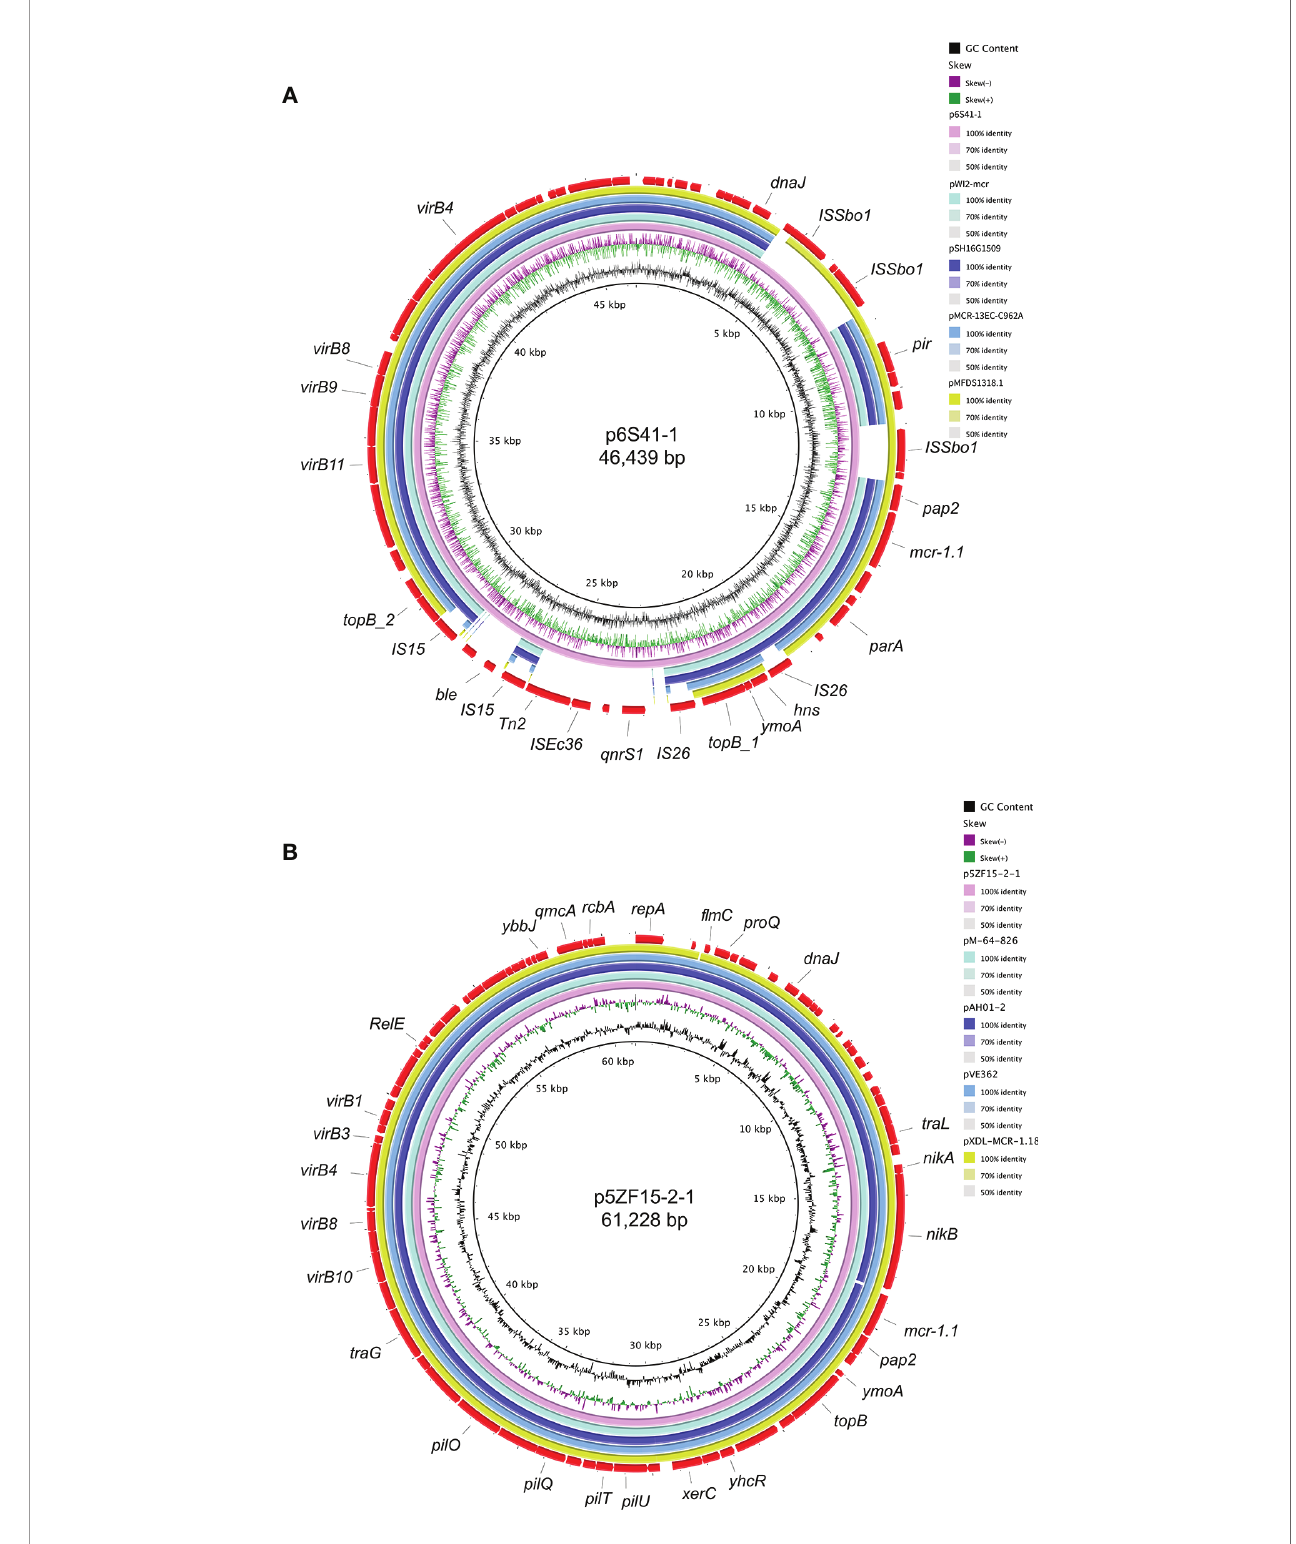
FIGURE 3 | The genetic features of plasmid p6S41-1 and p5ZF15-2-1. (A) Circular comparison between mcr-1 bearing IncX4 plasmids p6S41-1 in this study and four similar IncX4 plasmids in NCBI nr/nt database. p6S41-1 was used as the reference in the outermost ring. (B) Circular comparison between mcr-1 bearing IncI2 plasmids p5ZF15-2-1 in this study and four similar IncI2 plasmids in NCBI nr/nt database. p5ZF15-2-1 was used as the reference in the outermost